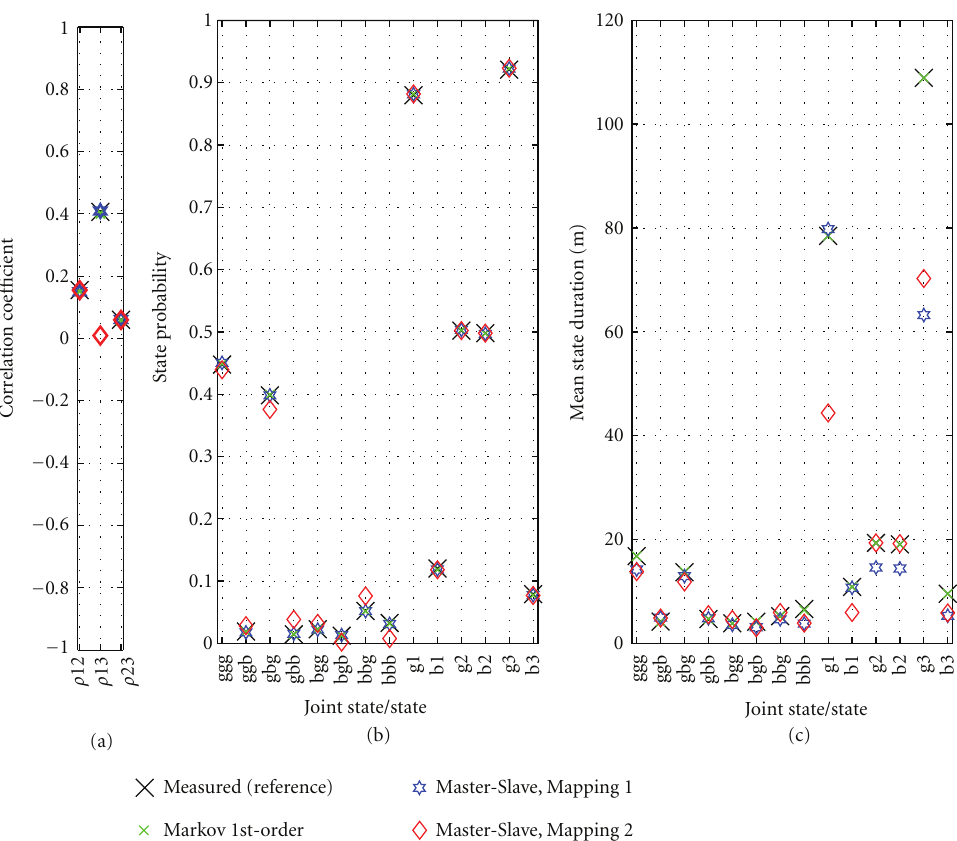
Figure 5: Correlation coe ffi cient (a), state probability (b), and mean state duration (c) for the three-satellite constellation mappings (Mapping 1 and Mapping 2) from Figure 4. Data was taken from measurements of 5.4 km length in a suburban environment. Resimulation gives the following results: clearly, the resulting correlation coe ffi cient between the slave satellites deviates for Mapping 2. The joint state probability is modelled accurately in case of Mapping 1, while Mapping 2 shows deviations. The mean state duration shows deviations in all cases (notation of states: g—“good,” b—“bad,” ggg—“good good good,”